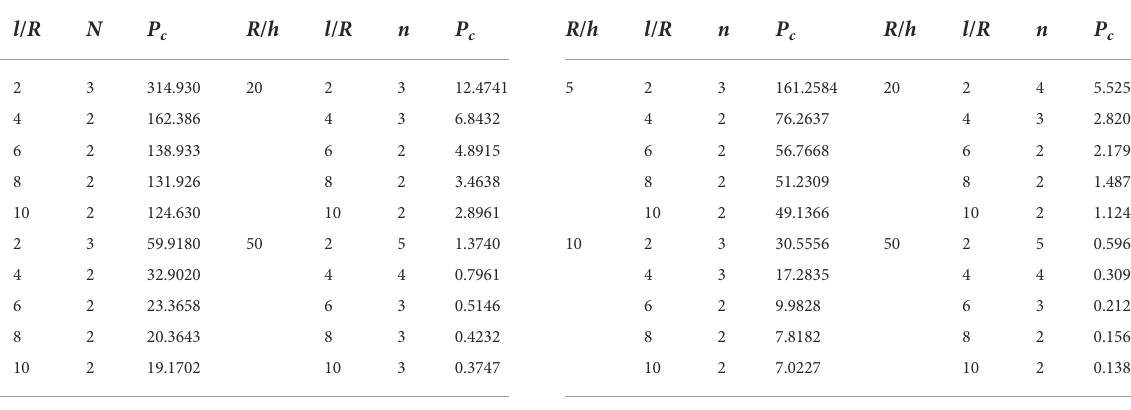
TABLE 5 Critical pressure values with [0/90/0]s con fi guration and Boron/Epoxy composite (MPa).